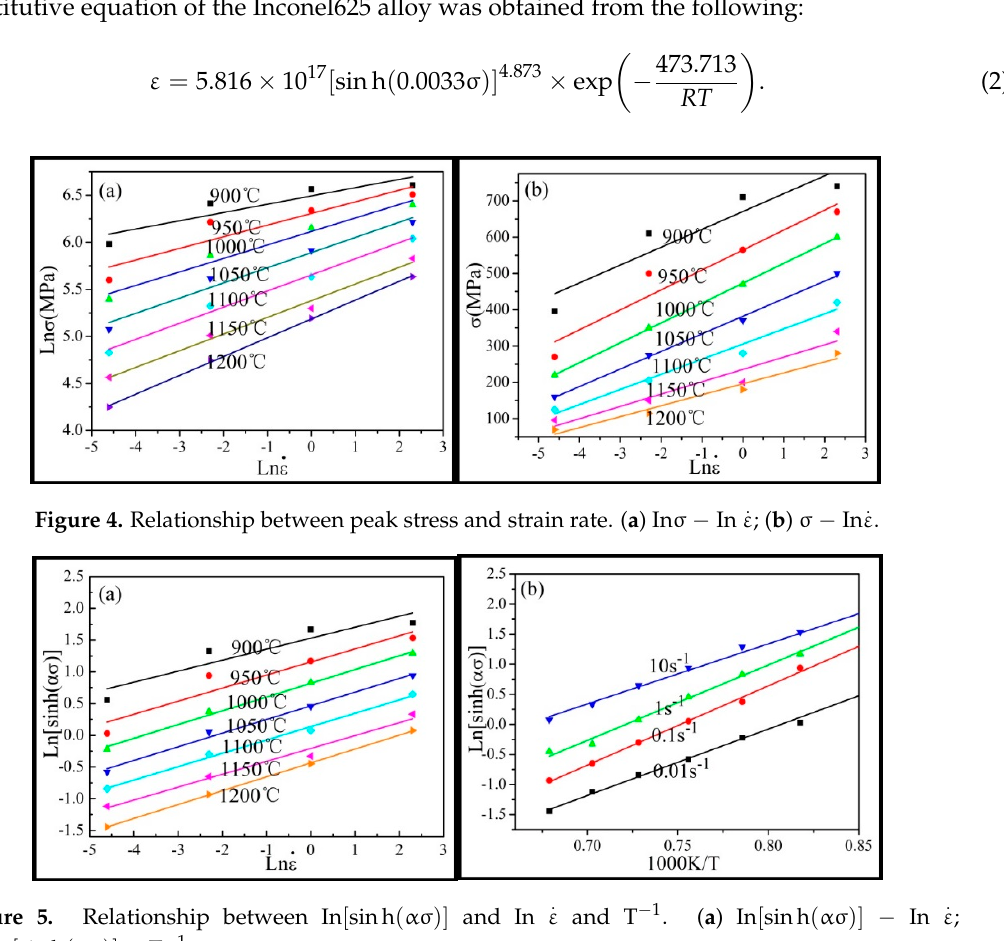
Figure 5. Relationship between In(cid:4670)sinh(cid:4666)ασ(cid:4667)(cid:4671) and Inε(cid:4662) and T − 1 . ( a ) In(cid:4670)sinh(cid:4666)ασ(cid:4667)(cid:4671) − Inε(cid:4662) ; ( b ) In(cid:4670)sinh(cid:4666)ασ(cid:4667)(cid:4671) − T − 1 .